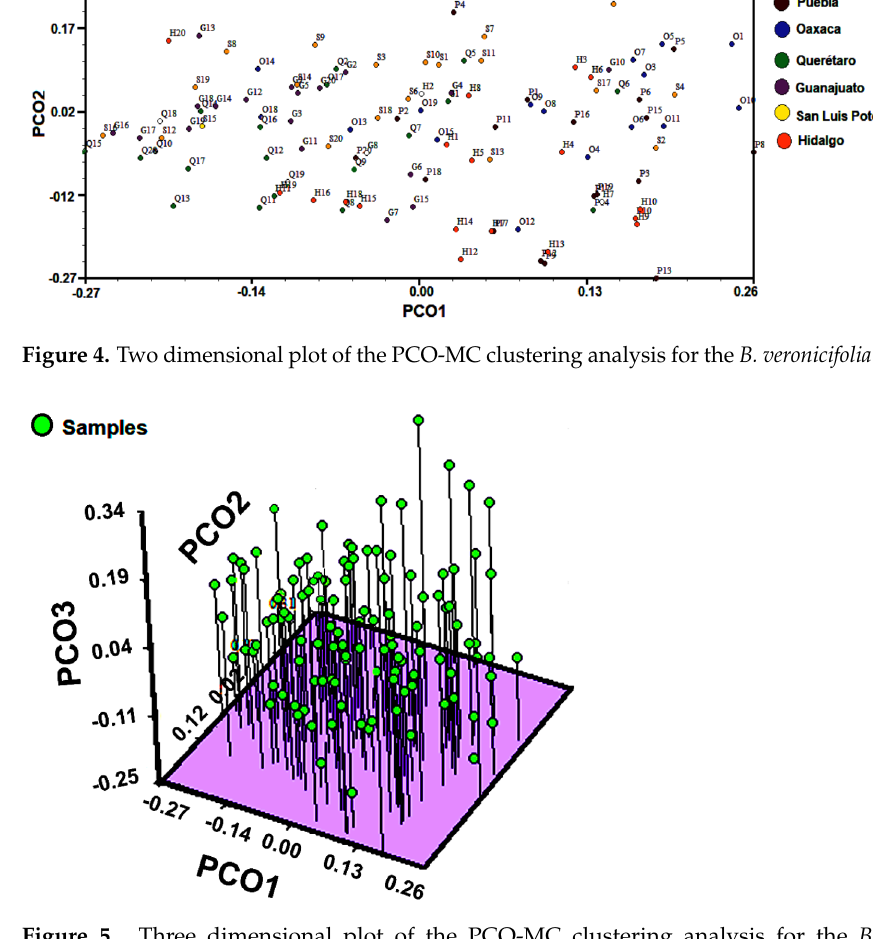
Figure 5. Three dimensional plot of the PCO-MC clustering analysis for the B. veronicifolia IPBS dataset.